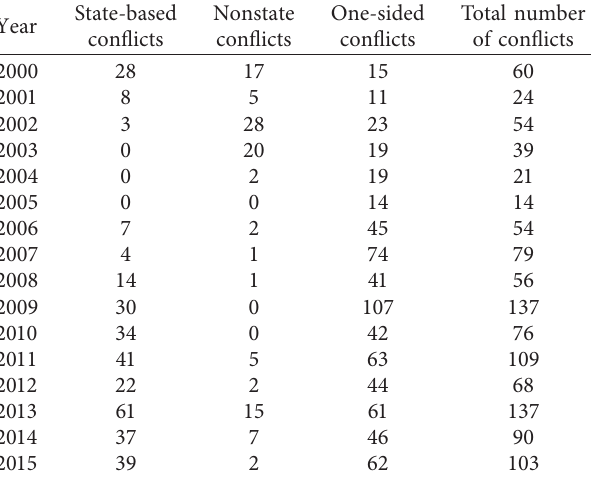
Table 1: Temporal distribution of armed